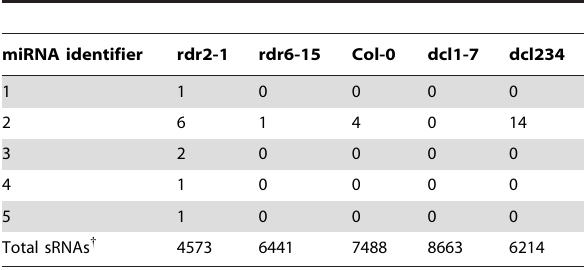
Table 3. Novel miRNA expression (454 raw values) in sRNA mutants and wild-type inflorescences*.